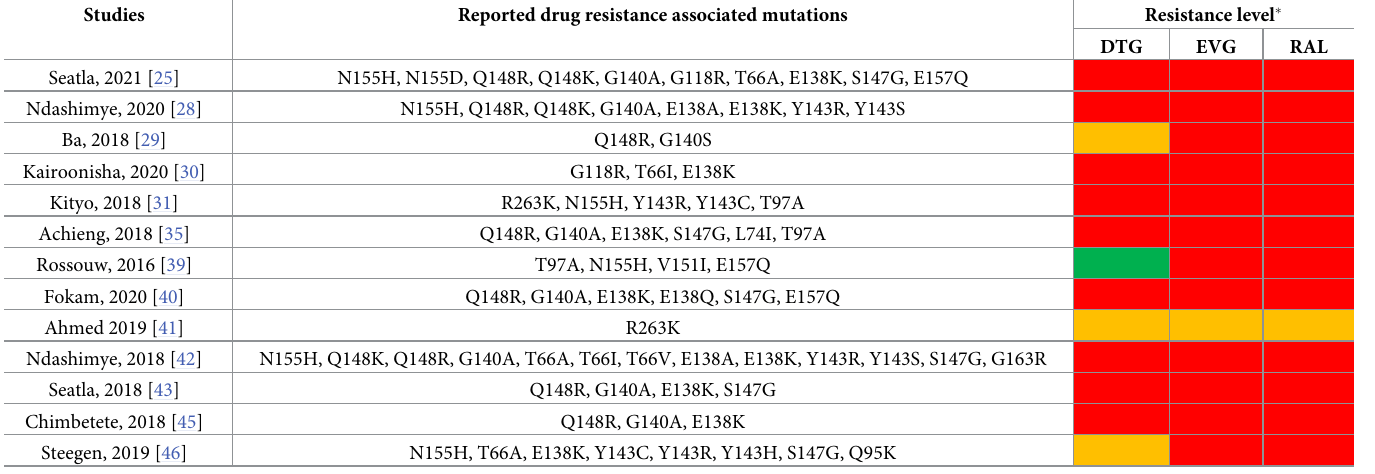
Table 3. HIV integrase mutations observed per study and corresponding levels of INSTI-resistance.